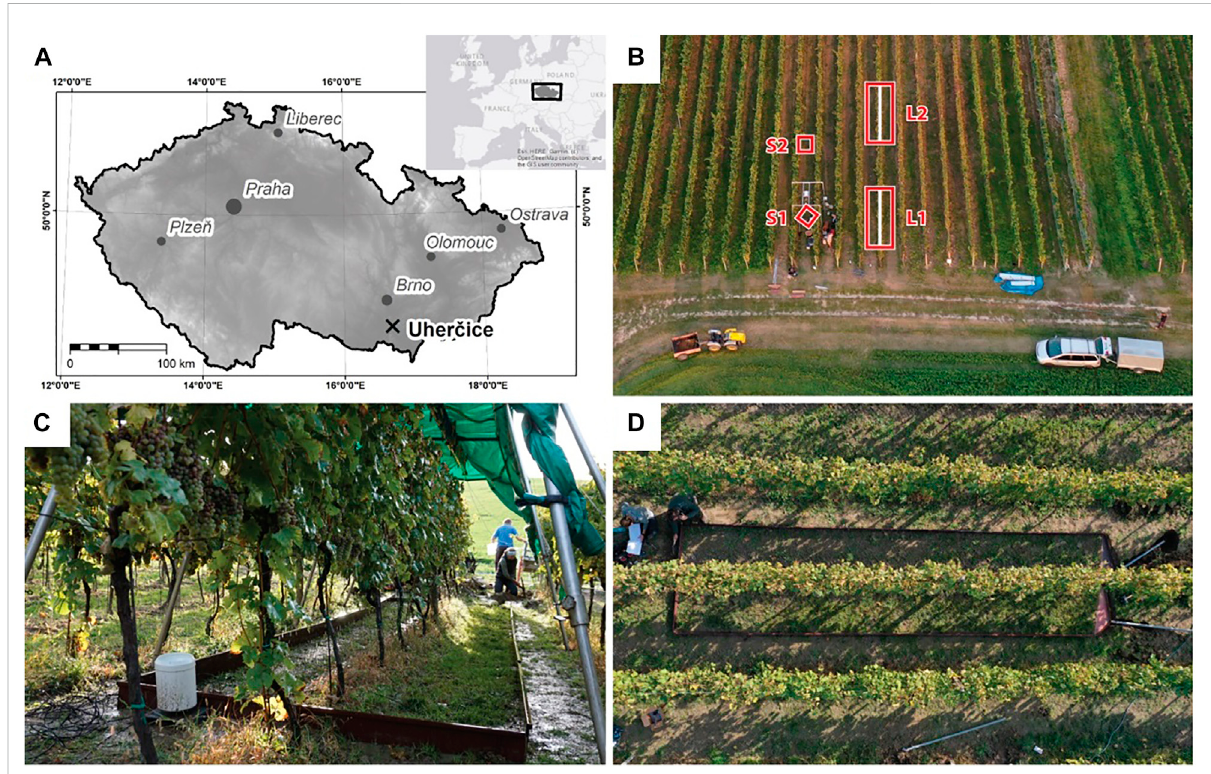
FIGURE 1 (A) Location of theexperimental area; (B) General overview of the study area; (C) detail ofvine plants, and (D) an aerial view of the placement of the large plot within the rows of vines. *S, small portable rainfall simulator; L, large rainfall simulator. 1 and 2 refer to the number of